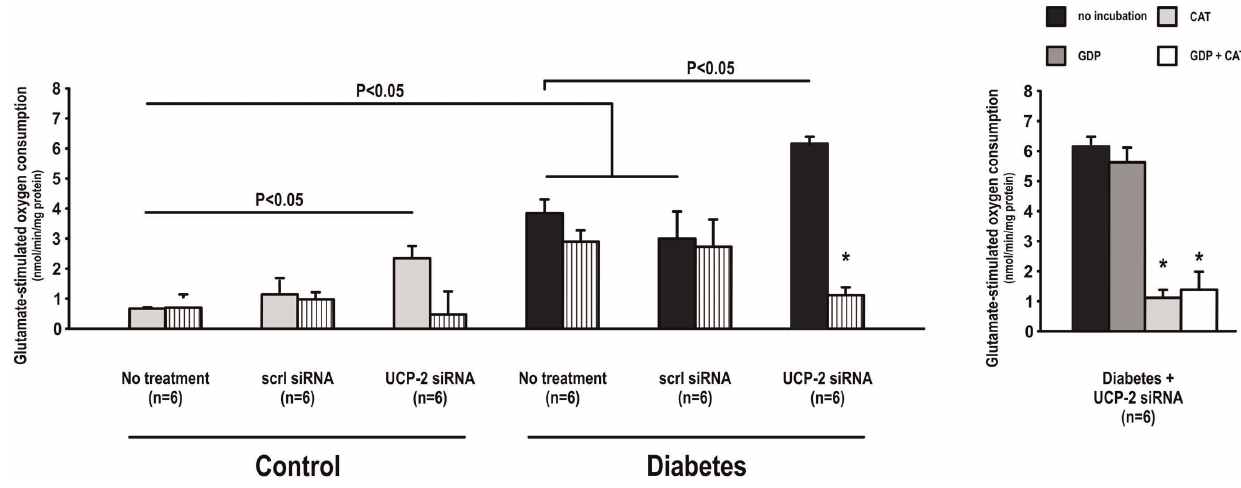
Figure 5. Mitochondria uncoupling measured as glutamate-stimulated O 2 consumption during inhibition of the ATP-synthase with oligomycin during baseline (filled bars) and after inhibition of ANT with CAT (patterned bars) in control and diabetic animals with